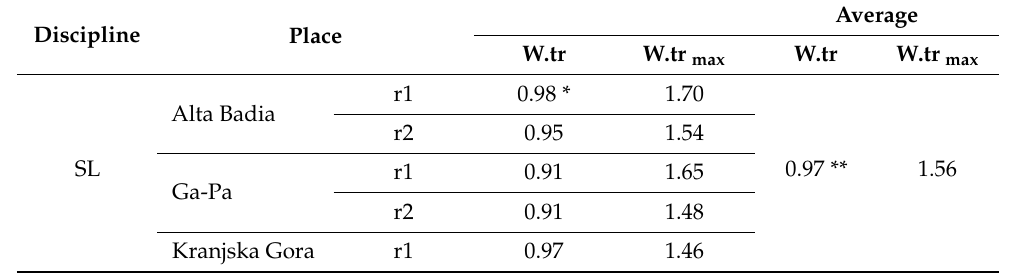
Table 1. Cont. Discipline